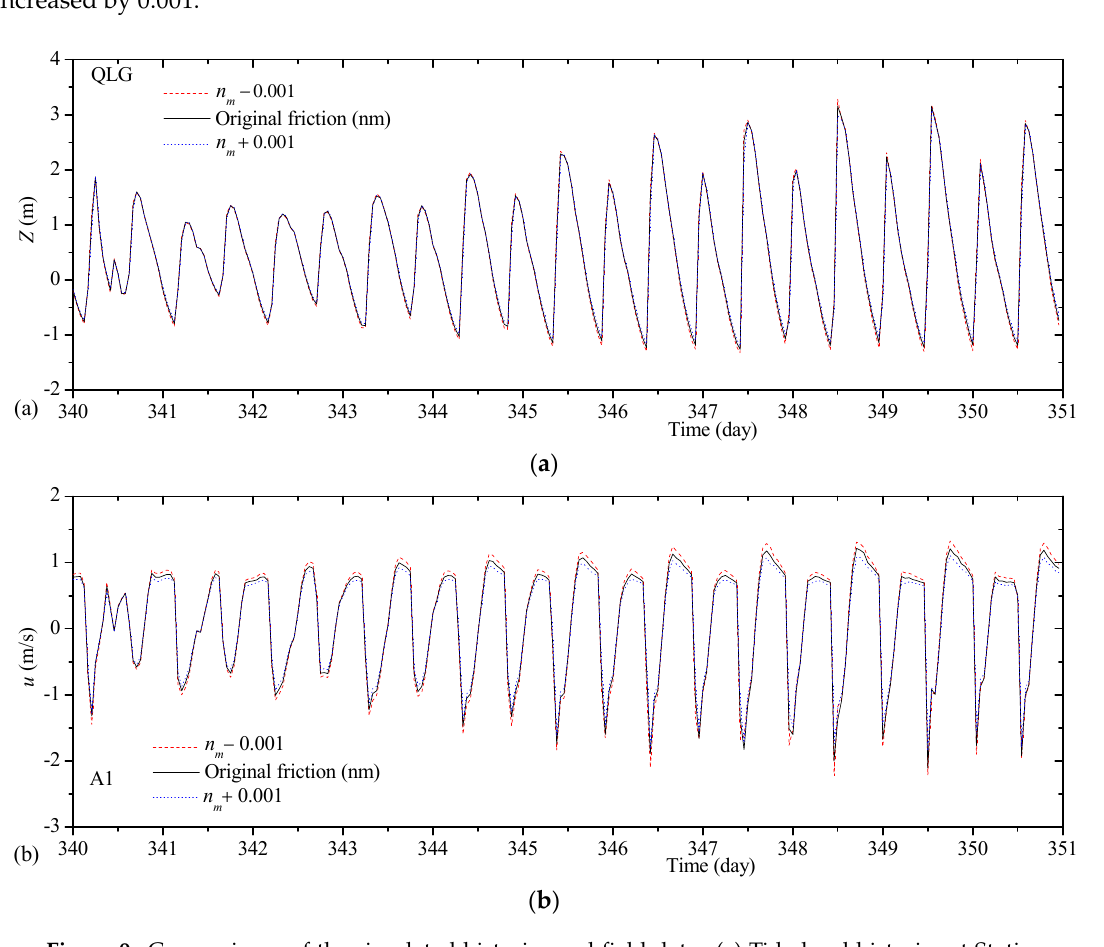
Figure 9. Comparisons of the simulated histories and field data. ( a ) Tide-level histories at Station Qinglonggang (QLG) and ( b ) velocity histories at Survey Point A1.